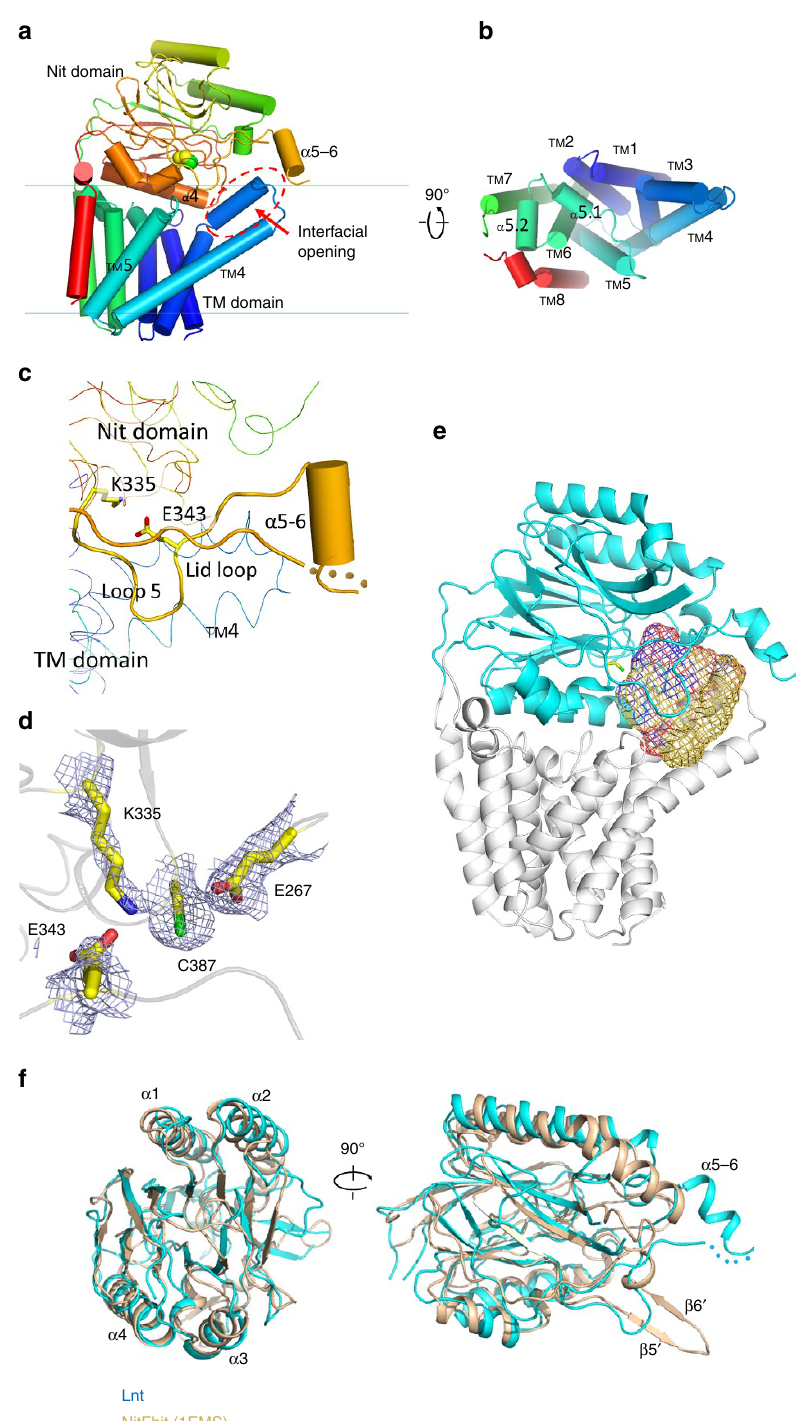
Figure 2 | Structure of E. coli Lnt. ( a ) The peptide chain of Lnt is shown in rainbow scheme from the N- (blue) to the C-terminus (red). The sidechain of the catalytic Cys387 is shown as sphere model, helices are shown as cylinders and b -strands are shown as arrows. The putative substrate entrance of the interfacial opening is marked with the red oval. ( b ) The TM domain is viewed from the periplasmic side, with the Nit domain removed for clarity. ( c ) Cartoon presentation of the lid loop and surround region. The missing residues (F 358 DL 360 ) in the lid loop are represented by dots. ( d ) Catalytic centre. Sidechains of the catalytic triad and Glu343 are shown in stick model. The 2Fo-Fc electron density map is contoured at 1- s level. ( e ) Substrate-binding cavity. The Nit and TM domains are shown as cyan and grey ribbons, respectively. The cavity was calculated with the programme EdPDB and shown as mesh using the programme PyMol. Cavity surface regions in contact with oxygen and nitrogen atoms are coloured in red and blue, respectively; otherwise in yellow. The catalytic residue Cys387 is shown as a stick model. ( f ) The two Nit domains are superimposed, and shown in ribbon presentations. E. coli Lnt is coloured in cyan, and Nit-Fhit (PDB ID: 1EMS) is in wheat colour. The root mean square deviation (r.m.s.d.) between the Nit domains of Ec-Lnt and C. elegans Nit-Fhit is 1.5Å (for 175 C a atom